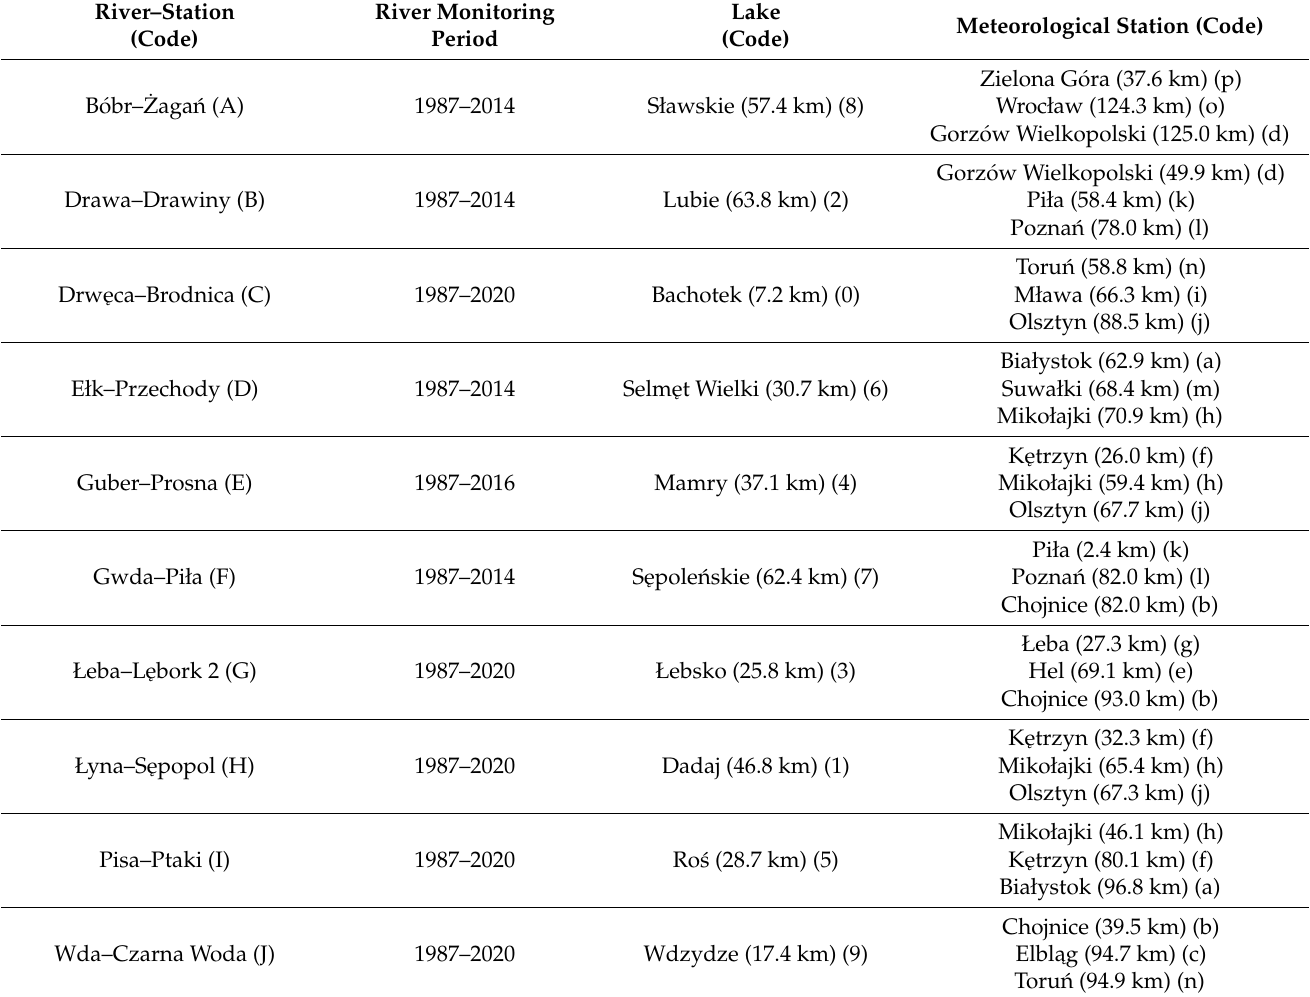
Table 1. River water temperature data—Institute of Meteorology and Water Management—National Research Institute. The locations of the stations are shown in Figure